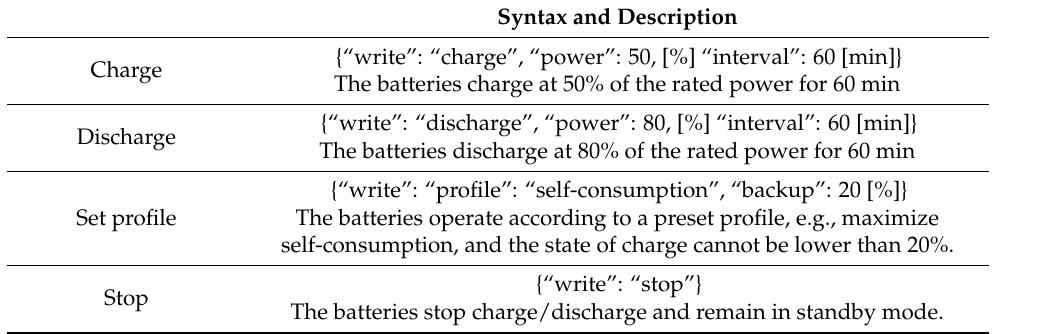
Table 4. List of write